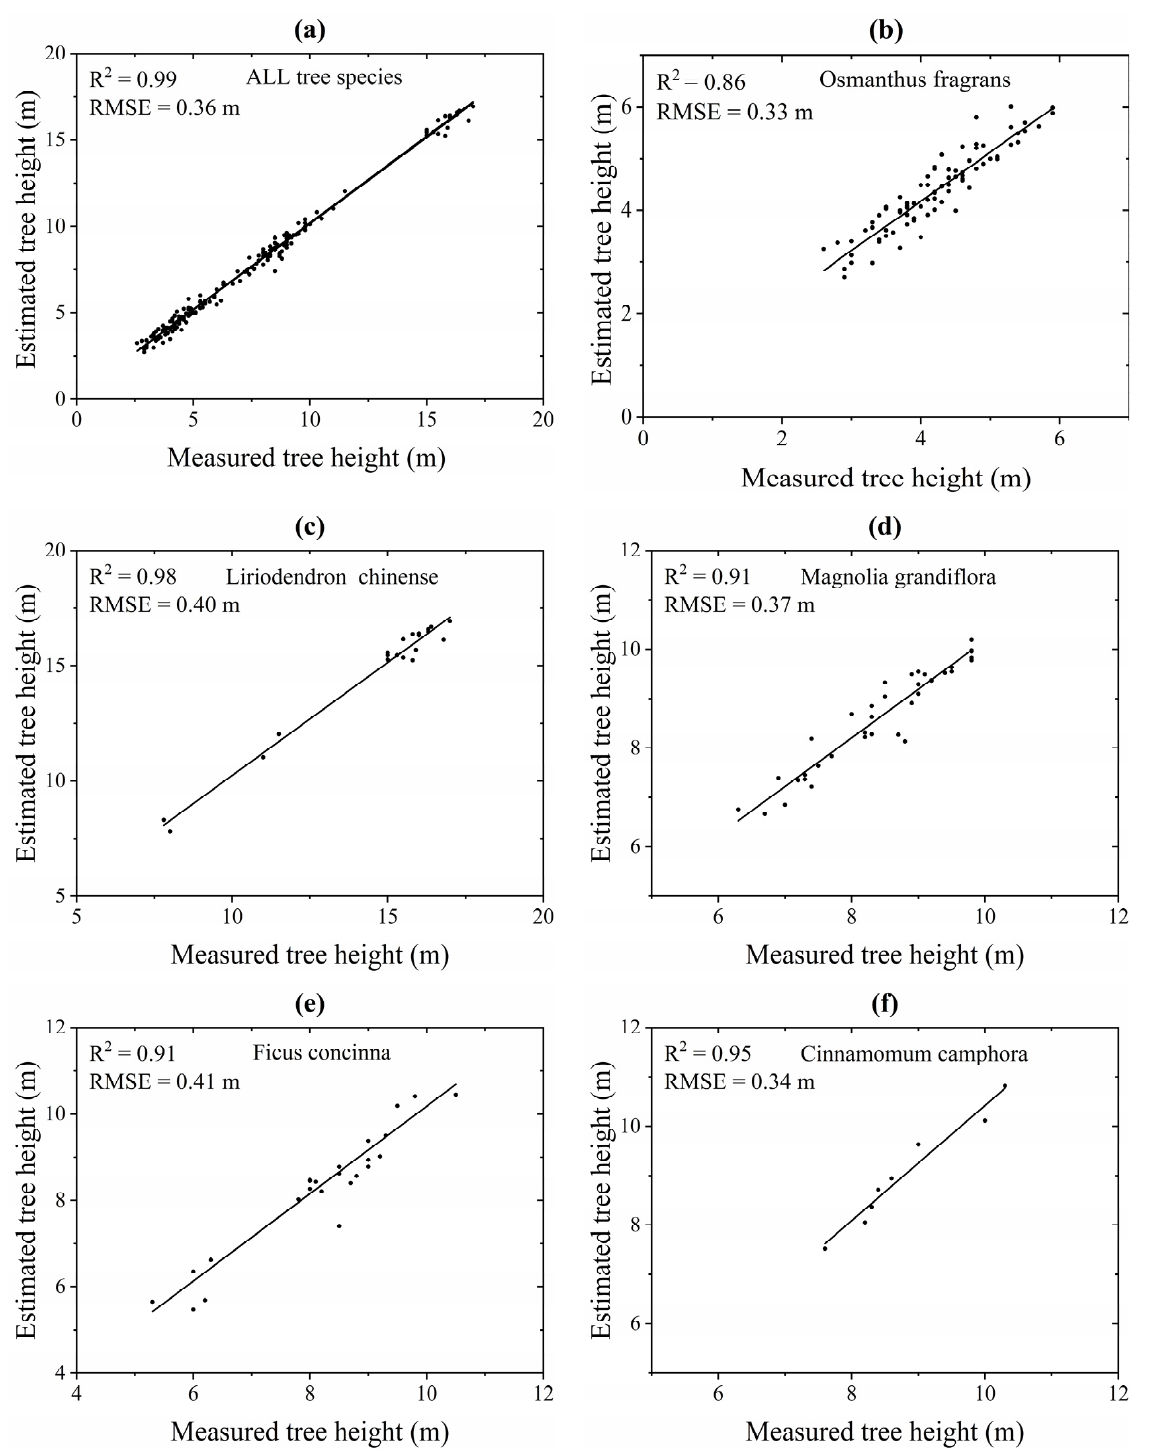
Figure 6. Tree height extraction results for different tree species.